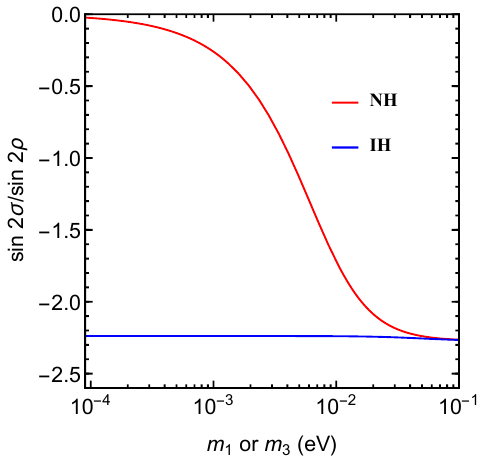
in the NH case or m in 1 3